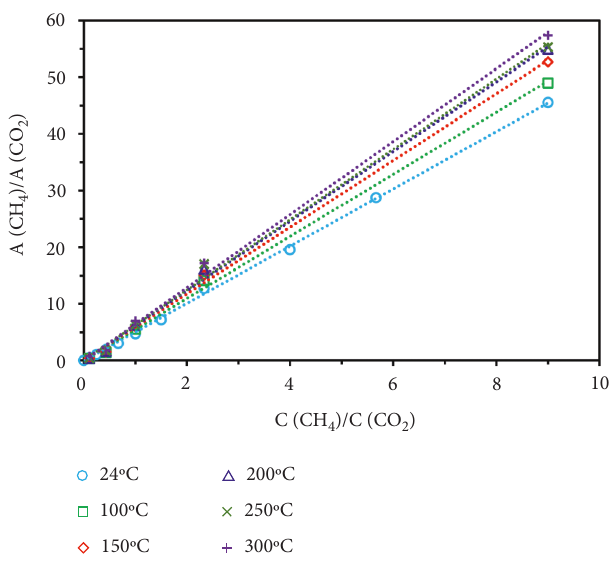
Figure 12: Raman peak area ratio between CH 4 and CO 2 as a function of their molar ratio at different temperatures.